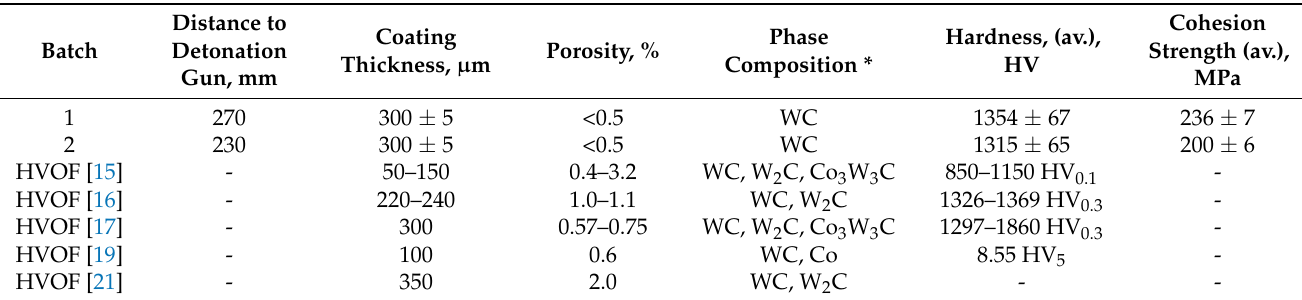
Table 1. Summary of the properties of deposited WC-Co-Cr detonation spray coating in comparison with literature data on the HVOF process.